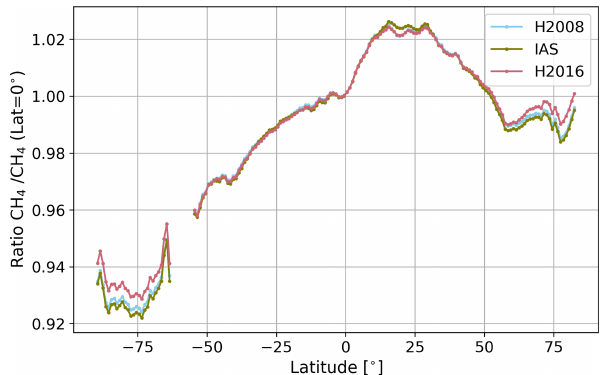
Figure 1. Latitudinal distribution of TROPOMI XCH 4 retrieved using HITRAN 2008 (blue), HITRAN 2016 (pink) and SEOM- IAS (green), referenced to the value at 0 ◦ latitude. Daily measure- ments from September 2018–September 2019 are gridded into a 0 . 2 ◦ × 0 . 2 ◦ grid, averaged longitudinally and then binned in 1 ◦ lat-